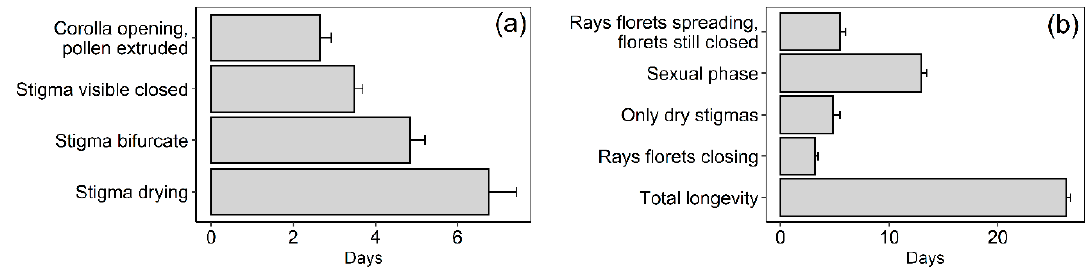
Figure 4. Potential floral longevity in M. subulata . ( a ) Duration of the male, neutral (stigmas emerging, not bifurcate), receptive stigma and dry stigma stages of individual florets (Mean + SE, N = 25). ( b ) Total longevity of pollinator-excluded flowers-heads (Mean + SE, N = 15) showing the duration of different stages.